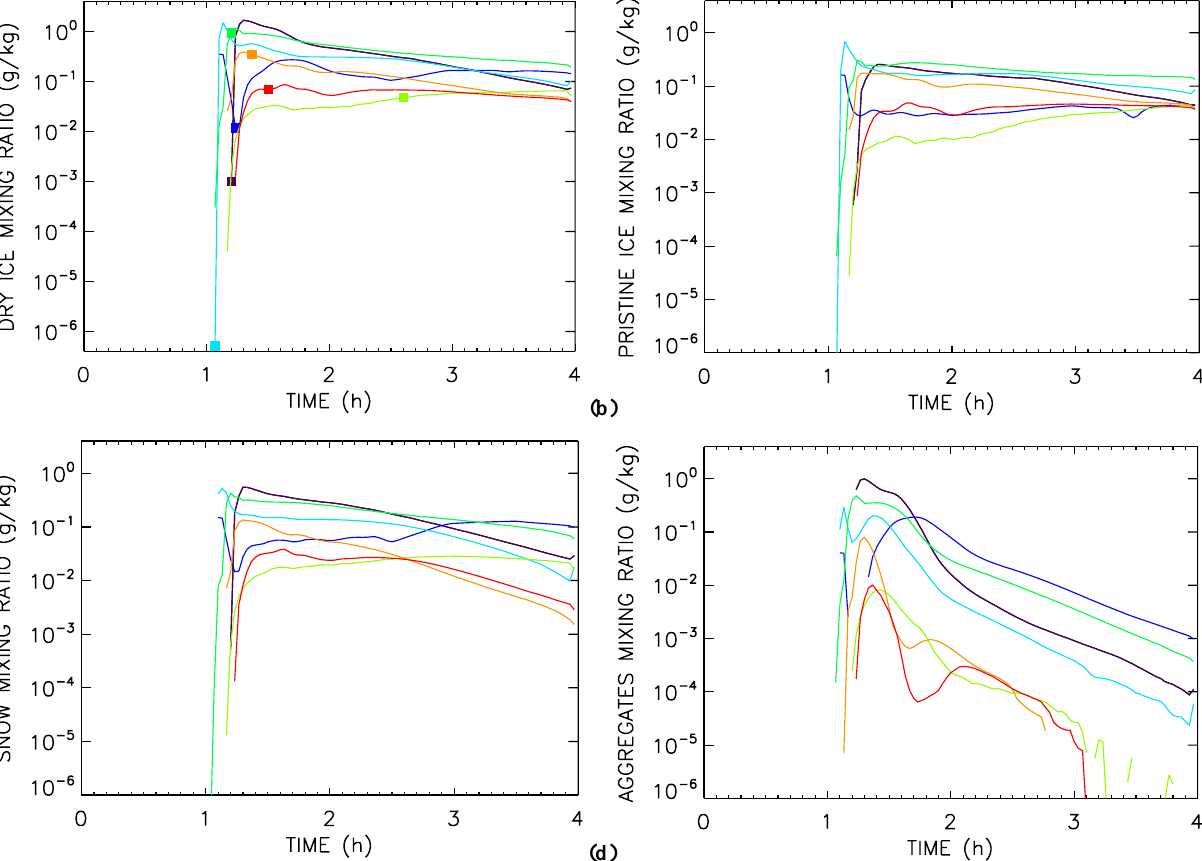
Fig. 4. (a) Dry ice mixing ratio in gkg − 1 versus time, (b) Pristine ice mixing ratio in gkg − 1 versus time, (c) , snow mixing ratio in gkg − 1 versus time and (d) aggregates mixing ratio in gkg − 1 versus time along the selected trajectories from the REF simulation. The dry ice mixing ratio is defined as the sum of pristine ice, snow and aggregates mixing ratios. On each trajectory of Fig. 4a, the full square indicates the time at which ice begins to grow by water vapour